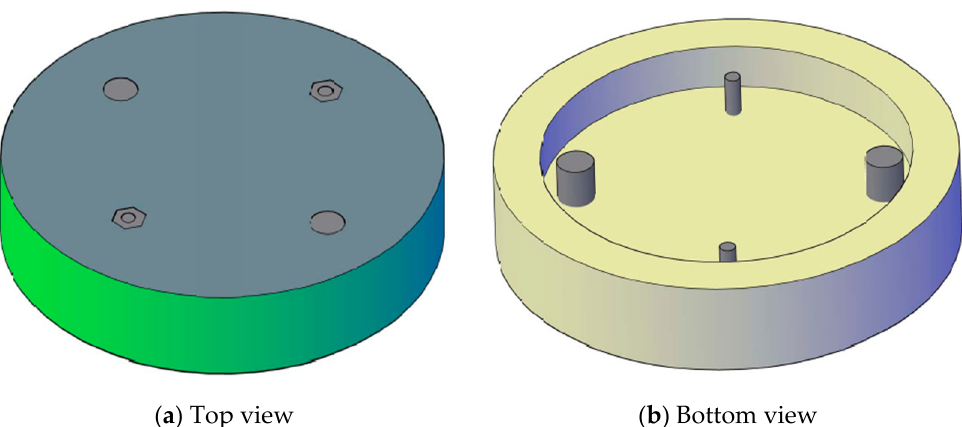
Figure 2. Schematic of the proposed sensor: ( a ) Top view; ( b ) Bottom view.